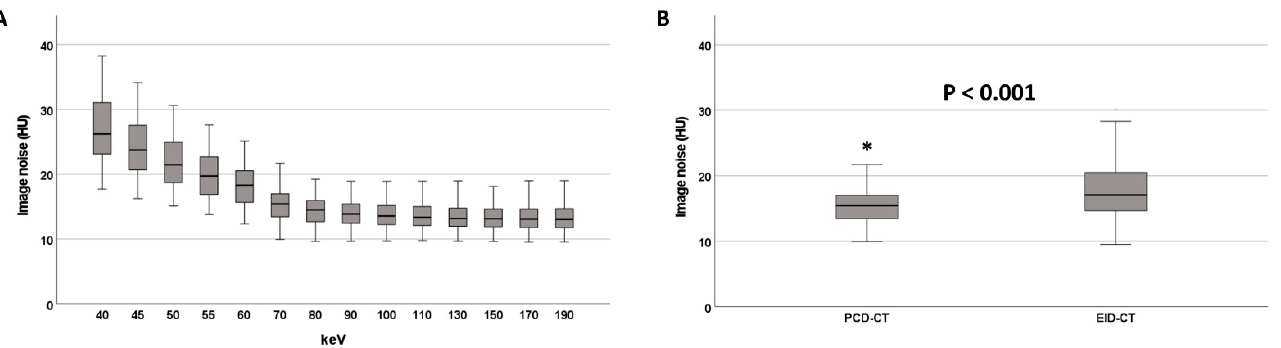
Figure 2. Image noise at different keV levels on the PCD-CT ( A ). Image noise on the PCD-CT (70 keV) and the EID-CT ( B ). * denotes an outlier value. Table 2. Tumor-to-liver ratio and contrast-to-noise ratio at different keV levels.